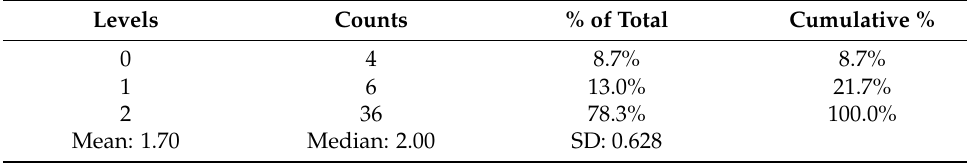
Table 2. “Number of Images” Score.